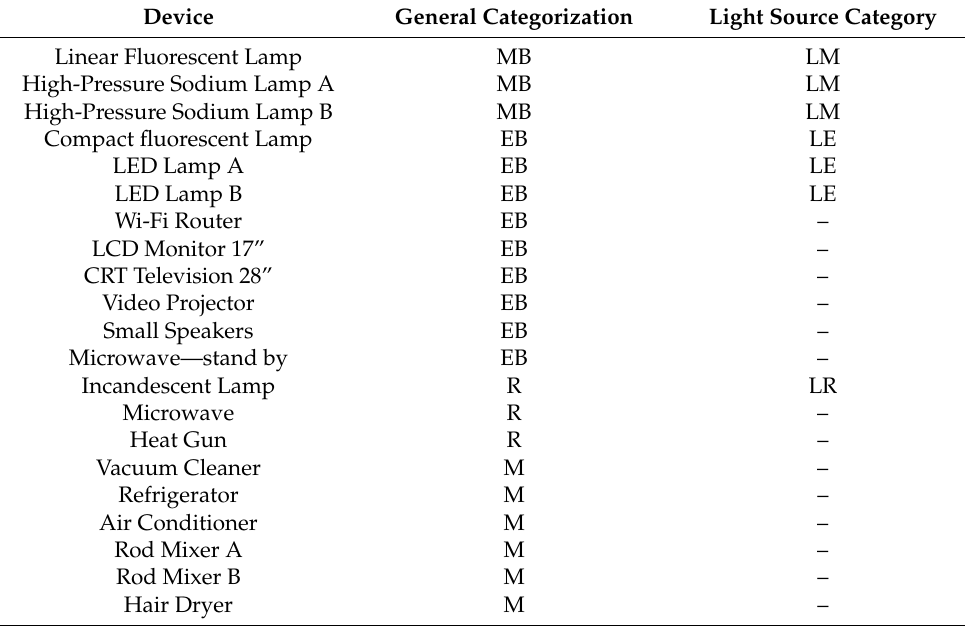
Table 2. List of categorizations of measured home appliances.